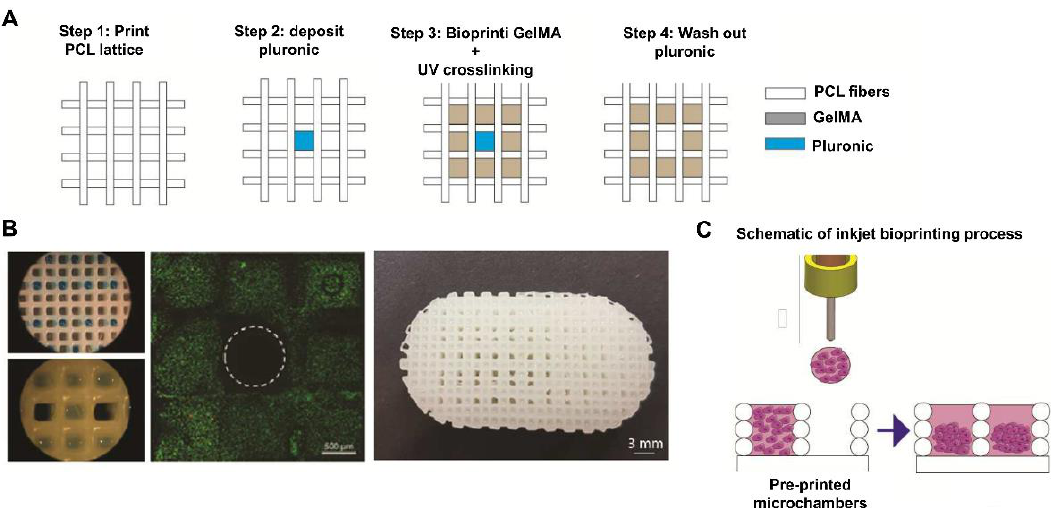
Figure 13. Multi-tool bioprinting procedure: ( A ) Schematic images of PCL printing and GelMA and pluronic bioprinting to create the bone region. ( B ) Macroscopic images of bioprinted scaffold. Live/dead analysis of MSC-laden GelMA bio-ink including microchannels after washing out pluronic. Scale bars = 0.5 mm and 3 mm. ( C ) Inkjet bioprinting procedure to obtain the cartilage part. Adapted from